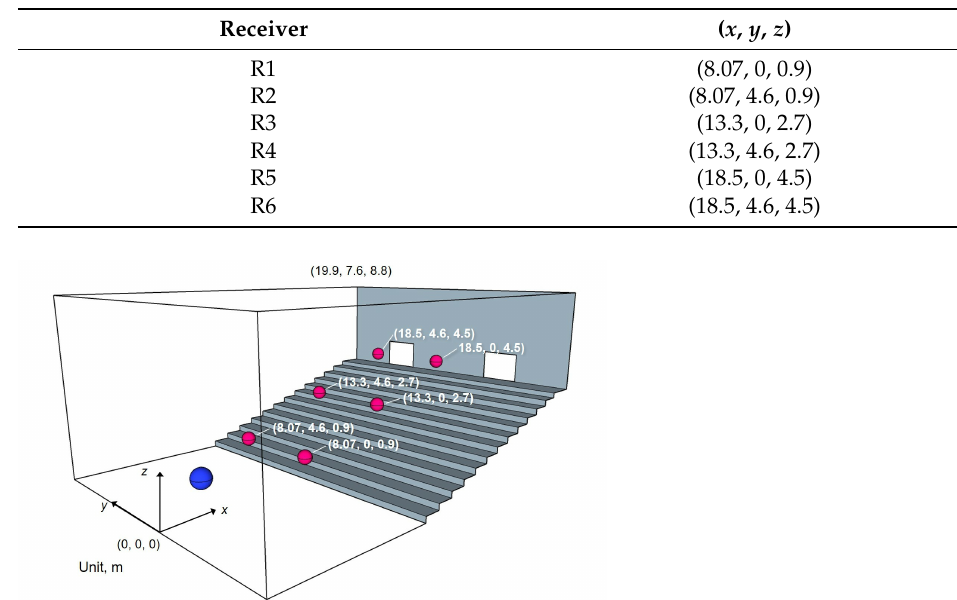
Table 2. Locations of receivers in the auditorium model.